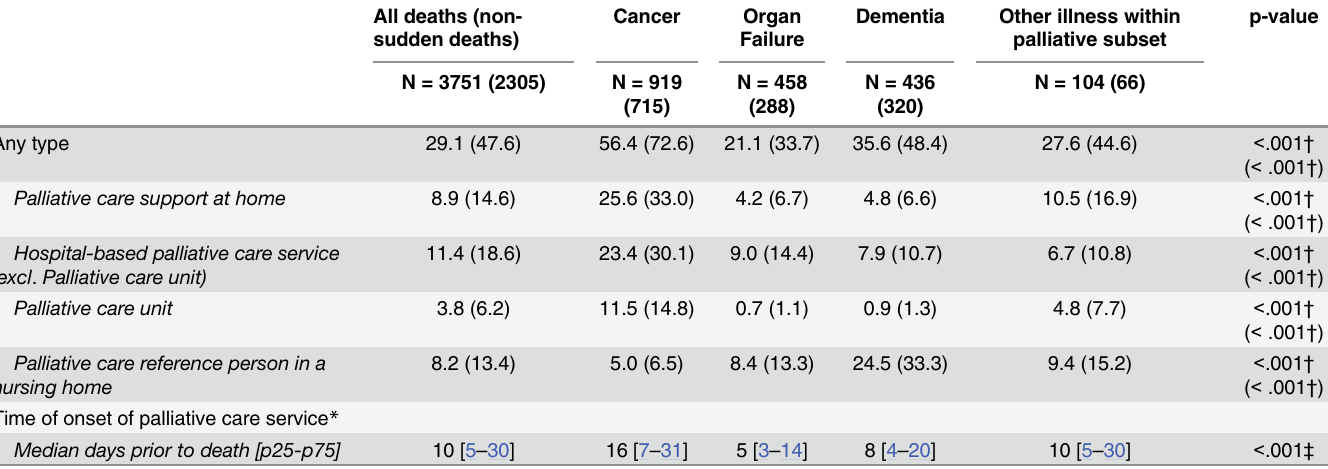
Table 2. Referral and time of onset of specialist palliative care services; % of all deaths (% of non-sudden